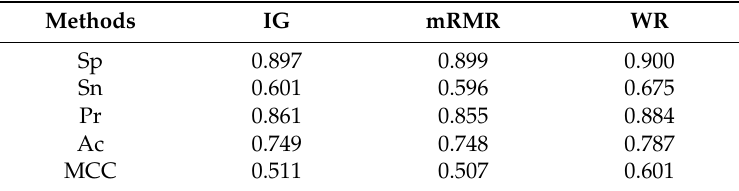
Table 5. Comparison with different feature selection schemes. IG—information gain; mRMR—minimum- redundancy–maximum-relevance; WR—Wilcoxon